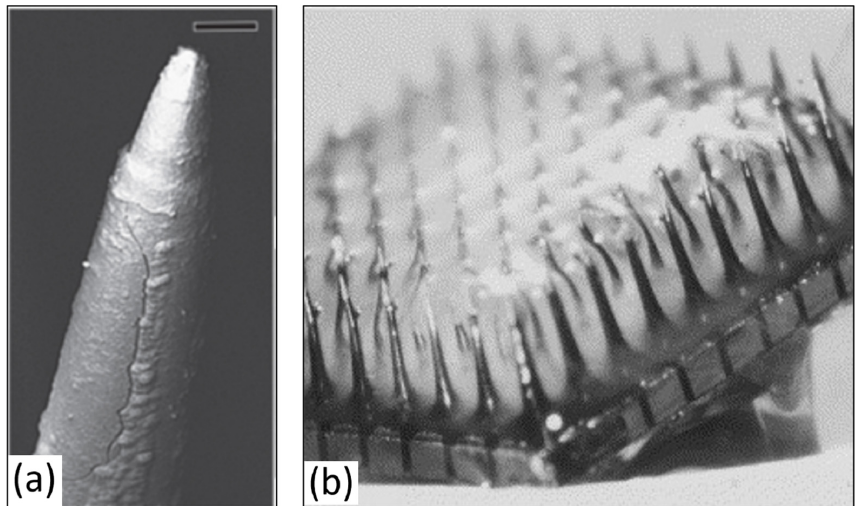
Figure 17. In vivo failures common in today’s heterogeneously integrated silicon-based neural probes. The Utah intracortical electrode array (Blackrock). ( a ) Side view of an electrode with a large longitudinal crack in the parylene-C insulation adjacent to surface irregularities (20 µm scale). ( b ) Explanted UIEA array at 10 months. The array was completely encapsulated. Reproduced with permission from Bernardin ©2018 [50].